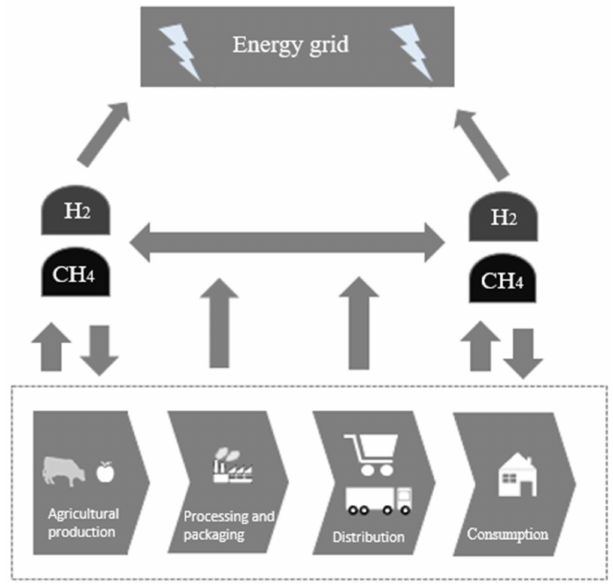
Figure 10. Outline of the proposed energy recovery